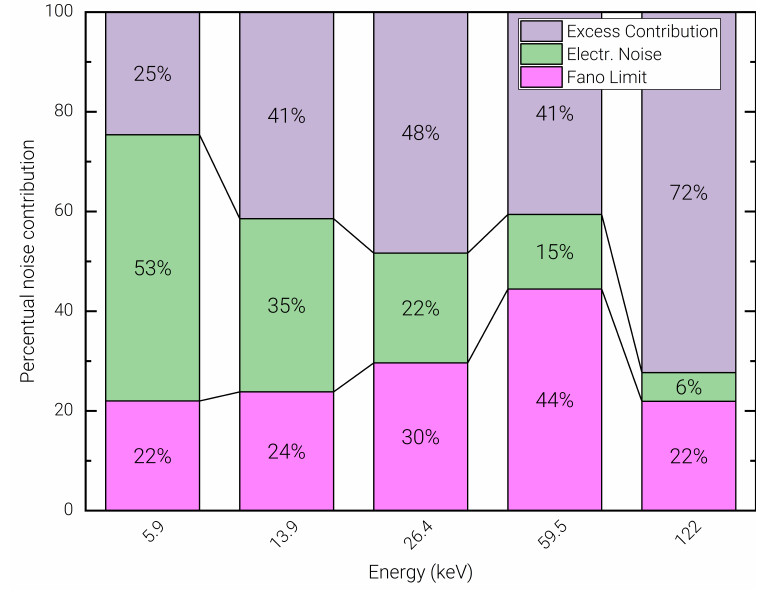
Figure 11. Percent contribution of Fano noise (pink), electronic noise (green), and measured excess contribution (purple) on the line FWHM for different photon